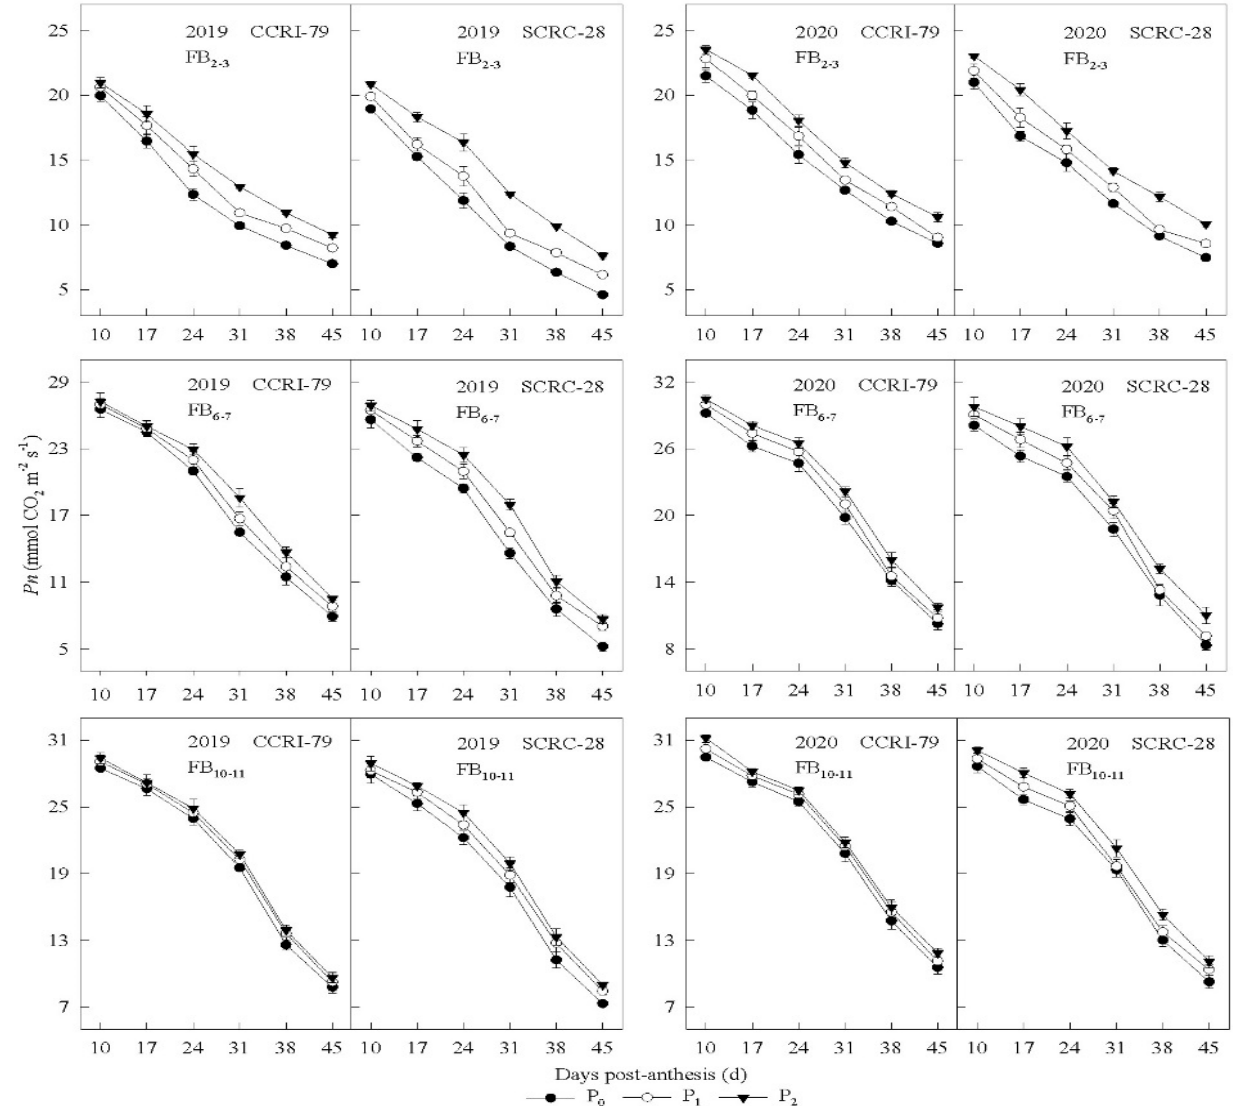
Figure 3. Theeffect of soil available phosphorus (AP) on the net photosynthetic rate ( Pn ) ofsubtending leaves in 2019 and 2020 cotton-growing seasons. d: day. FB: fruiting branch. P 0 : 3 ± 0.5 mg kg − 1